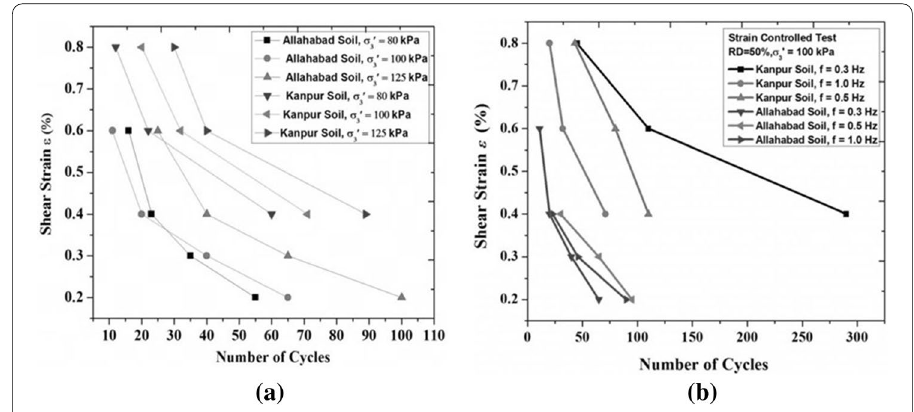
Fig. 8 Comparative study of shear strain and number of cycles for initial liquefaction for Kanpur and Allahabad soil. a Effective confining pressure Hz. b Applied frequency